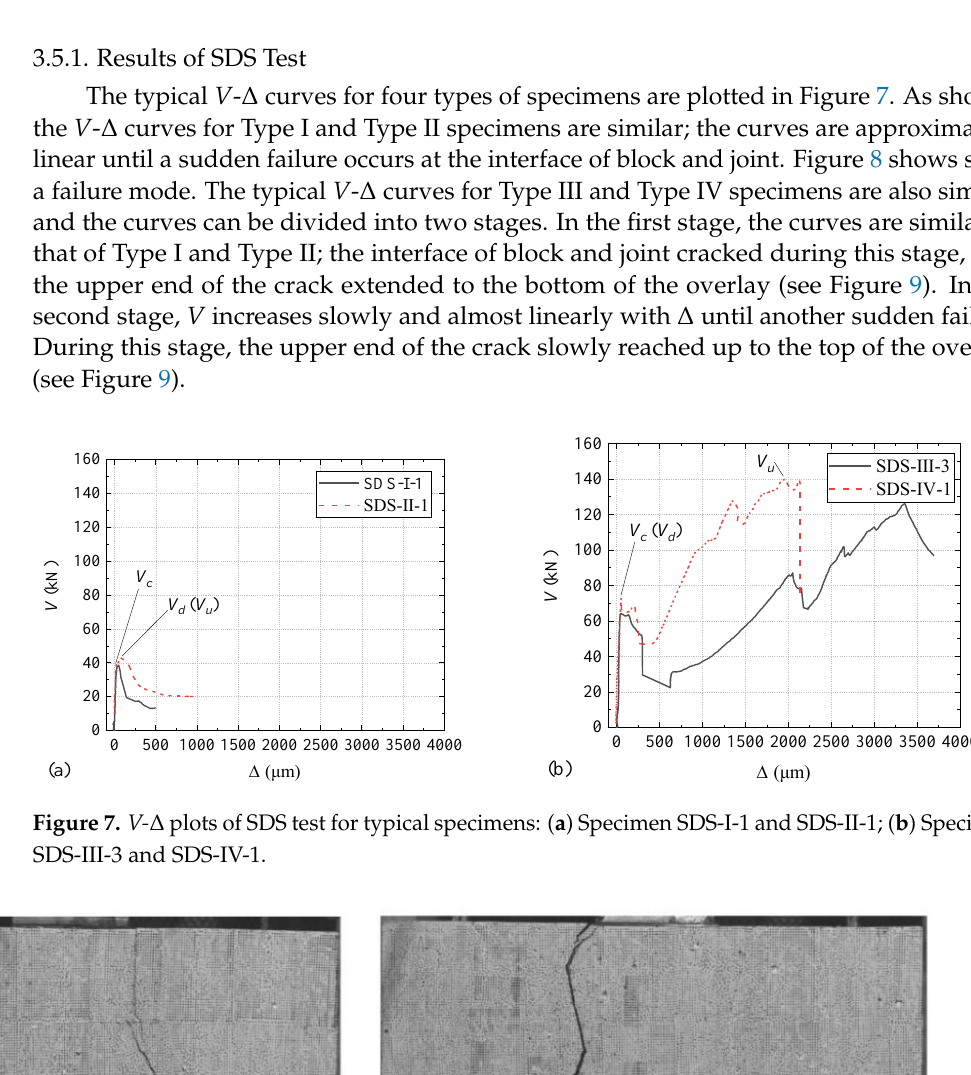
Figure 8. Failure modes of specimens: ( a ) Type I specimen; ( b ) Type II specimen. The cracking shear force ( V c ), the maximum shear force in the first ascending stage force in the whole process ( V u ), the corresponding slips across the joint ( ∆ p and ∆ u ),